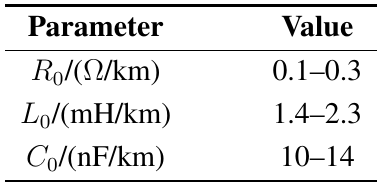
Table 1. The electrical parameters of the traction line.